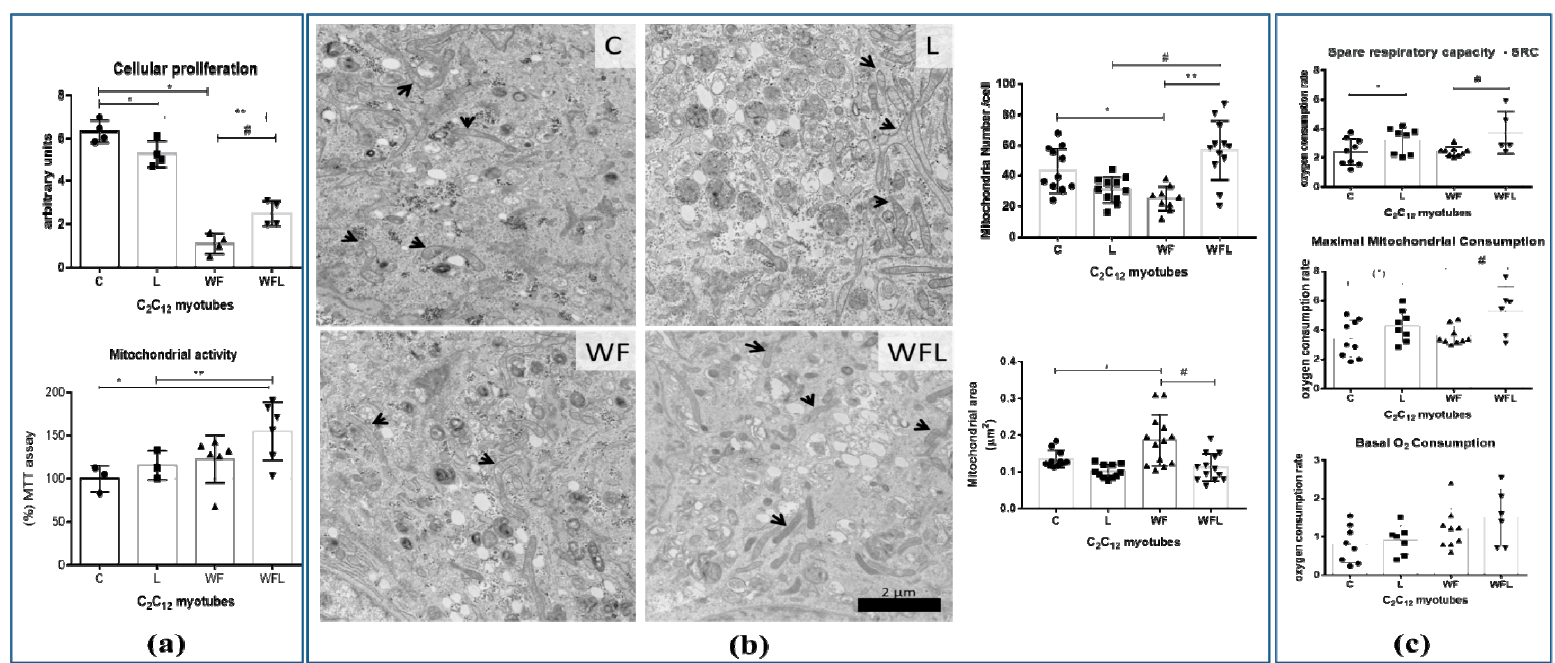
Figure 3. C 2 C 12 myotubes parameters under Walker Factor effects and modulation by leucine treatment. ( a ) In vitro MTT assay for assessing cell mitochondrial activity in C 2 C 12 myotubes subjected to Walker Factor and leucine supplementation. ( b ) Representative ultrastructure images of mitochondria from C 2 C 12 myotubes. Groups without tumour presented a greater number of mitochondria, when compared to the other tumour-bearing groups (W and WL). The leucine supplemented tumour-bearing group (WL) had more mitochondria than the tumour-bearing group fed a control diet (W). Magnification 10000×. Scale bar: 2µm, arrows indicate mitochondria. Bar graphics show the mitochondrial number and area for each group. ( c ) Basal O 2 mitochondrial consumption; maximal mitochondrial respiration and spare respiratory capacity of the C 2 C 12 myotubes measured in Oroboros Oxygraph-2K and DatLab software package (OROBOROS, Innsbruck, Austria). Experimental design applied on myotubes cells were sequentially treated with Oligomycin A (1 µM), FCCP (0.5 µM), and Antimycin A (1 µM) as indicated by the arrows. For more details see Material and Methods section. Leucine-treated C 2 C 12 myotubes were incubated with leucine (50 µM, Sigma) for 24 h. Tumour-treated C 2 C 12 myotubes were incubated for 24 h with Walker Factor at final concentrations of 25 µg/mL. Leucine/Walker Factor-treated C 2 C 12 myotubes were exposed to 50 µM leucine and supplemented with tumour Factor at final concentrations of 25 µg/mL. For more details see Material and Methods section. Legend: control (C); leucine supplementation medium (L); Walker Factor treatment (WF) and Walker Factor treatment and leucine supplementation medium (WFL). * p < 0.05 difference against C group; ** p < 0.05 difference against L group: # p < 0.05 difference against WF group.